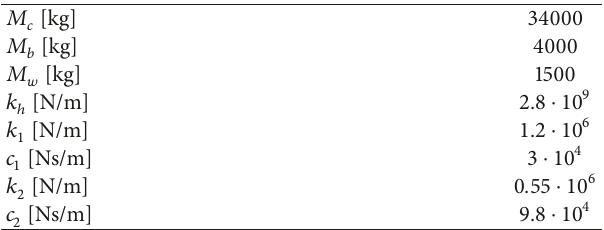
Table 2: Main characteristics of the